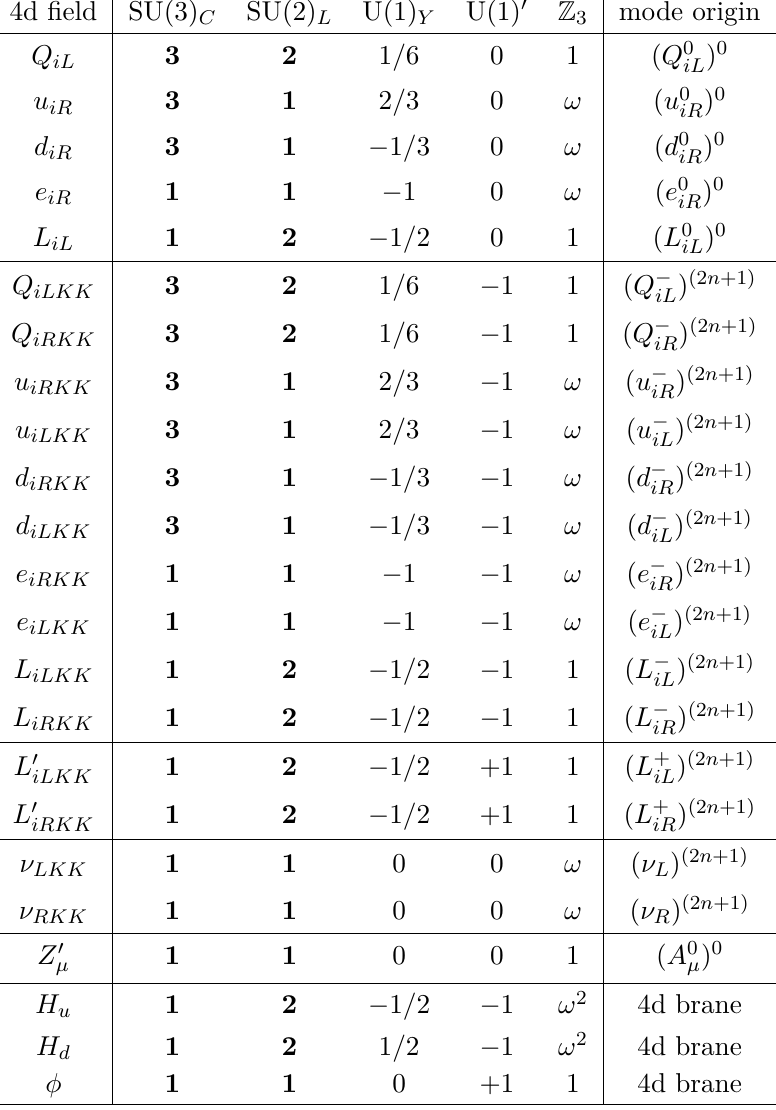
Table 2 . Field content in the effective 4d theory and their mode origin in the 5d expansion. All 4d fermion fields are left-handed Weyl spinors but they originate from 5d Dirac fermion modes with left (L) and right (R) handed components as shown in the last column (where the R components have been CP conjugated to yield left-handed Weyl spinors). The left-handed SM fermion states without a KK subscript correspond to the lowest Kaluza Klein modes having zero KK mass contributions in the 4d effective theory. We only show the KK fermion modes with positive U(1) 0 charge since they play a role in generating quark and lepton Yukawa couplings. There will be other KK fermion modes (not displayed) of all three isocharges ± 1 , 0 , arising from SO(3) triplets, which similarly form massive vector-like pairs of left-handed Weyl spinors with conjugate quantum numbers. For example, we display L 0 , which has negative U(1) 0 isocharge, since it plays a role in the type iKK Ib seesaw mechanism. The neutrinos ν KK arising from SO(3) singlets do not have any massless modes. The spin-1 Z 0 field originate from the 5d SO(3) gauge field. The φ scalar is located in the µ πR/ 2 brane. The two scalar Higgs doublets H u ≡ H − , H d ≡ H − are the isocharge negative 4d u d brane fields arising from the isotriplet Higgs on the zero